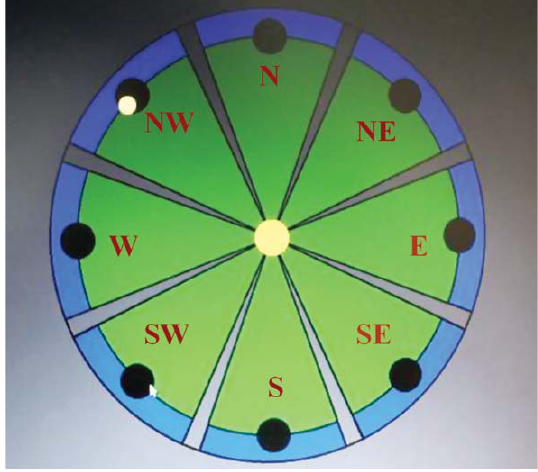
Fig. 3. The “clock-like” robotic therapy rehabilitative